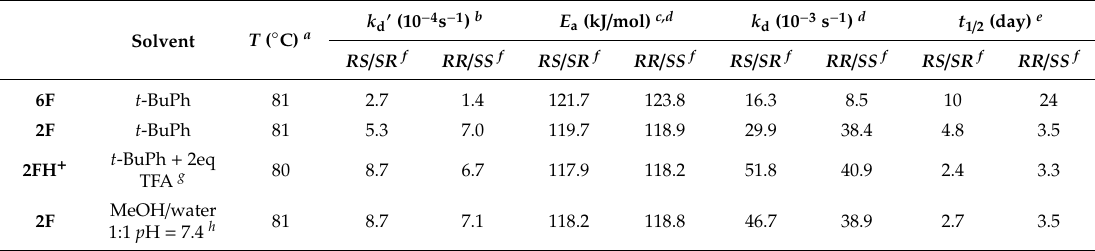
Table 3. Experimental homolysis rate constant k d ’ for alkoxyamines 16 , 2F , 8F , 9F , 2G and 6G using the EPR technique and Equation (2), in various conditions, corresponding activation energies E a , re-estimated homolysis rate constant k d at 120 ◦ C, and half-lifetime t 1 / 2 at 37 ◦